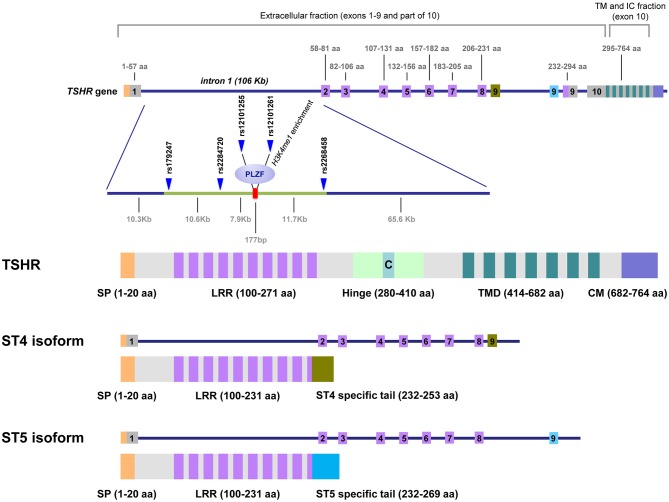
TSHR gene, GD-associated intron 1 polymorphisms and the predicted proteins expressed as cell-anchored proteins and as soluble forms. This figure shows the unique structure of TSHR. Intron 1 contains the GD-associated SNPs scattered on a region of ~30 kb at the 5′ end of intron 1. The numbers on top of the gene diagram correspond to the amino acids coded by each exon. The numbers on the bottom of the gene are the distances in kilobases (Kb). The primary associated SNPs are labeled in addition to the area of histone 3 lysine 4 monomethylated (H3K4me1), where the repressor factor, PLZF, was found to bind, reducing TSHR transcription. The exons used exclusively by the ST4 and ST5 isoforms are labeled in green and blue, respectively. The TSH holoreceptor (TSHR) and the two short isoforms (ST4 and ST5) are depicted, showing that the short isoforms contained less than half of the potential immunogenic regions of the receptor, including a large proportion of the extracellular domain, specially the hinge. C, C peptide; SP, signal peptide; LRR, Leucine Reach Repeats; TMD, transmembrane domain; CM, Cytoplasmic Motifs [This figure is based on Figure 1 and Figure 2 of manuscript (9). Reproduced with permission of Thieme editorial].